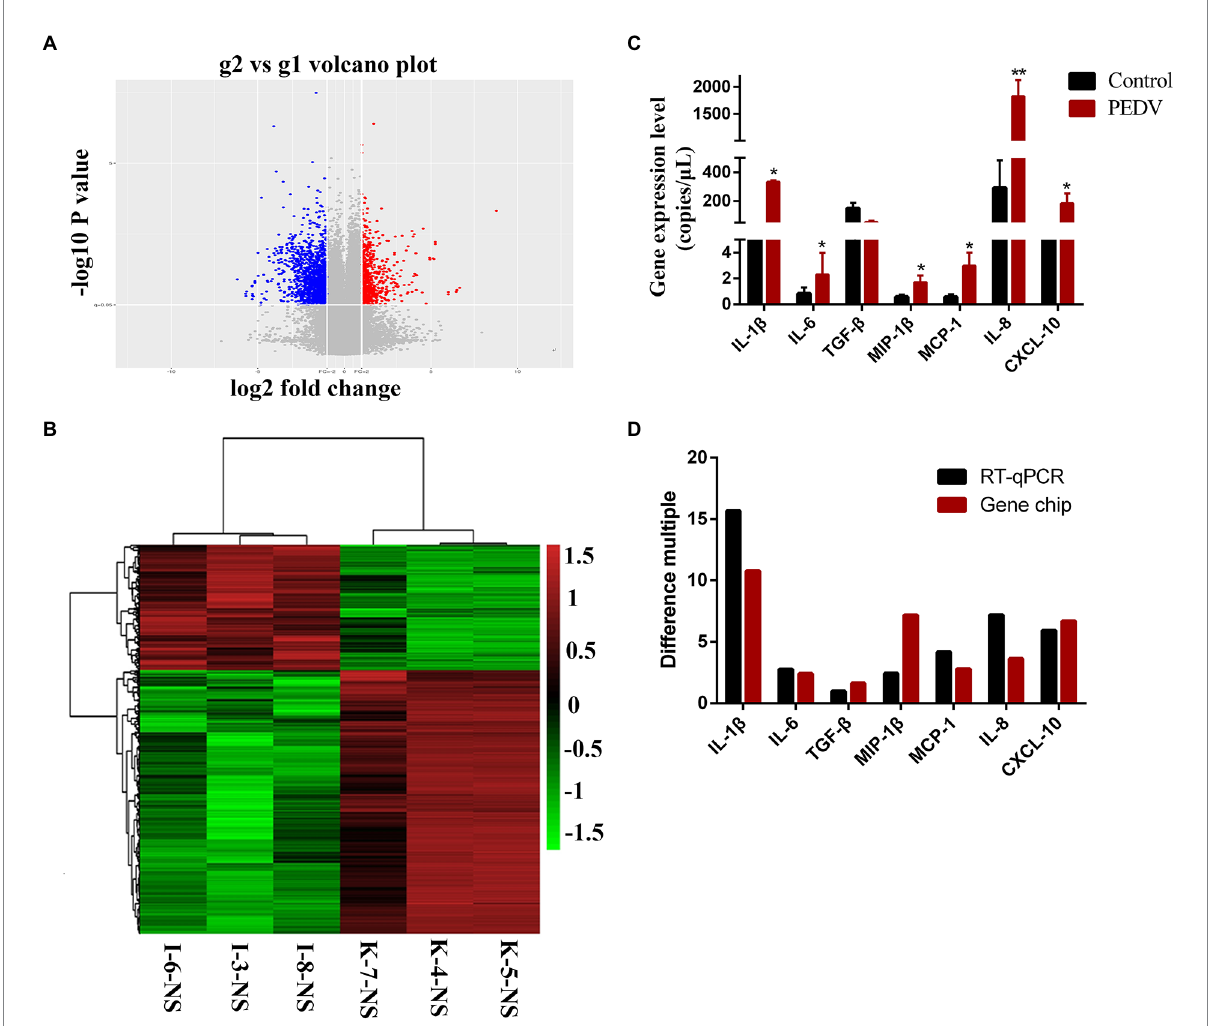
FIGURE 5 Expression levels of cytokines in ileum of piglets orally inoculated with PEDV. (A) The volcano drawing of ileum tissues plot of cDNA microarray. g1 represents ileum tissue of piglets in control group. g2 represents ileum tissue of piglets in PEDV infected group. The ordinate is the -lg ( p -value) value. The abscissa is log2 (Fold Change). (B) Ileum of heat map of cDNA microarray. K, Negative control piglet; I, PEDV-infected piglet. (C) The expression levels of the cytokines gene copies in ileum of the PEDV-HBQY2016 infected and the negative control group were quantitatively determined via qRT-PCR. (D) Comparison of fluorescent quantitative PCR and gene chip results in ileum of piglets. *Represents a significant difference relative to the control group ( p < 0.05), **Represents an extremely significant difference relative to the control group ( p <